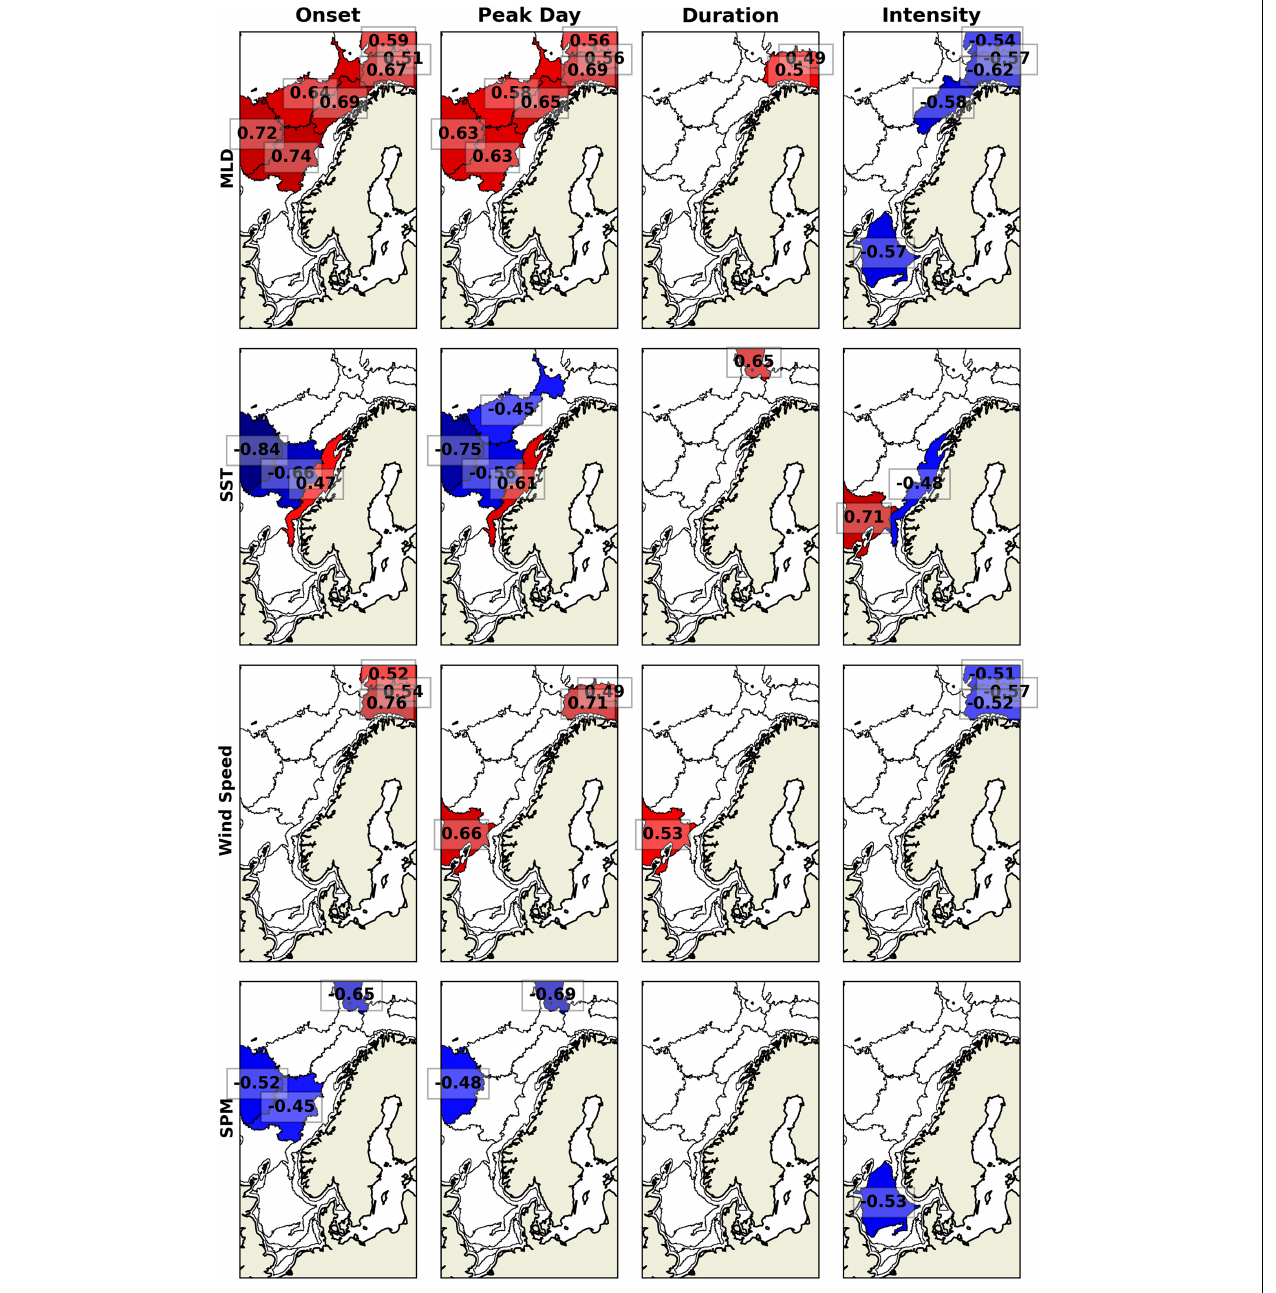
FIGURE 6 | Detrended interannual correlation between the spring bloom phenology and MLD, SST, wind speed, and SPM. Red colors are positive correlations, blue colors are negative correlations and white colors are used for insignificant correlations ( α > 0.05).